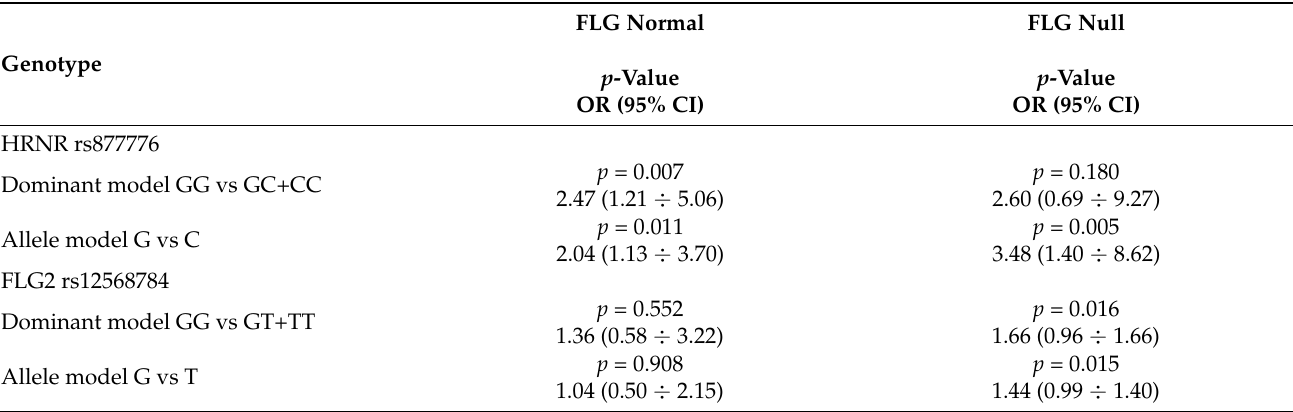
Table 4. Atopic eczema risk after stratification for FLG